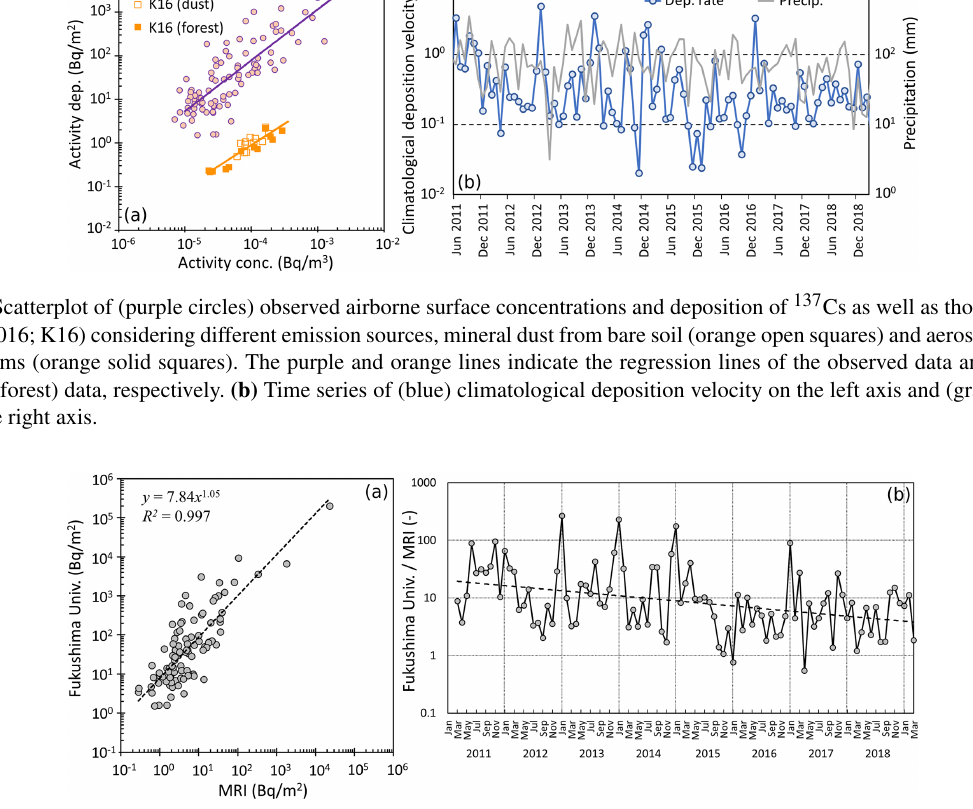
eling distance of an aerosol with a diameter of several tens of micrometers is on the order of 10 km (Kajino et al.,